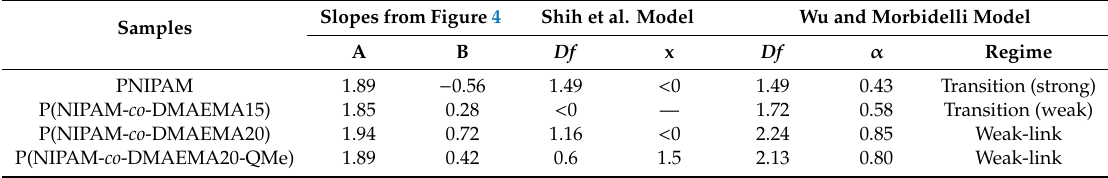
Table 1. Summary of the results obtained by applying Shi et al., and Wu and Morbidelli’s fractal models. Slopes from Figure 4 Shih et al. Model Wu and Morbidelli Model Samples A Regime